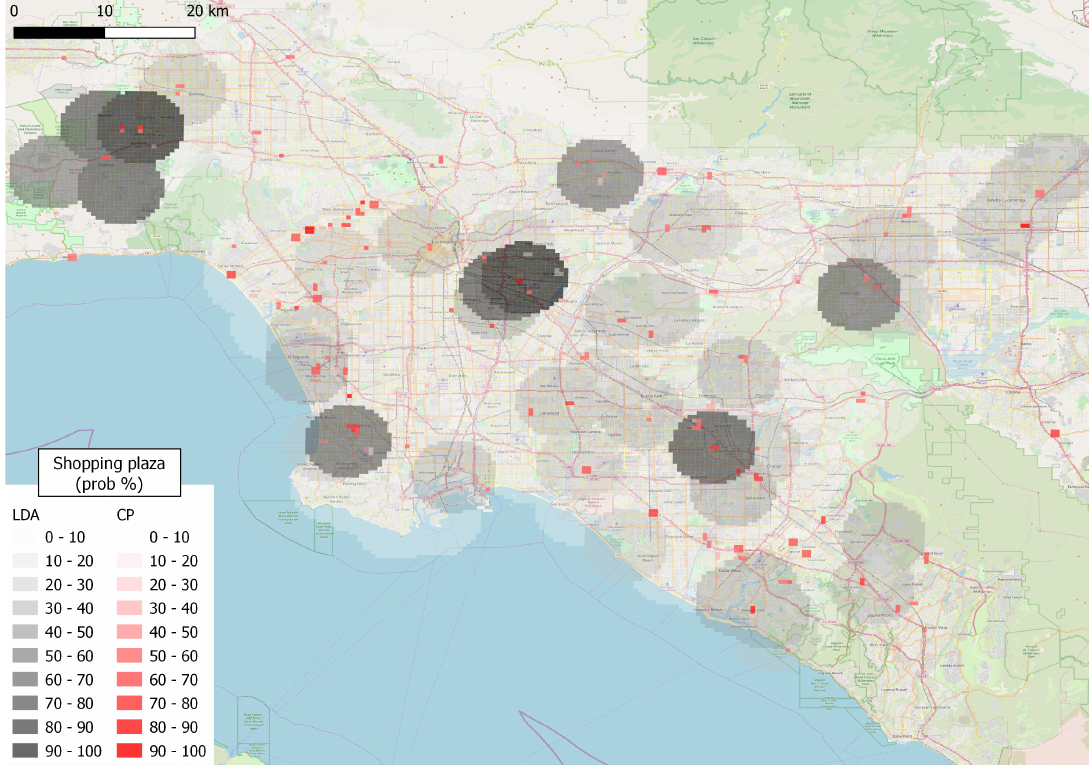
Figure 2. Shopping plazas in Los Angeles using LDA- and pattern-based approaches